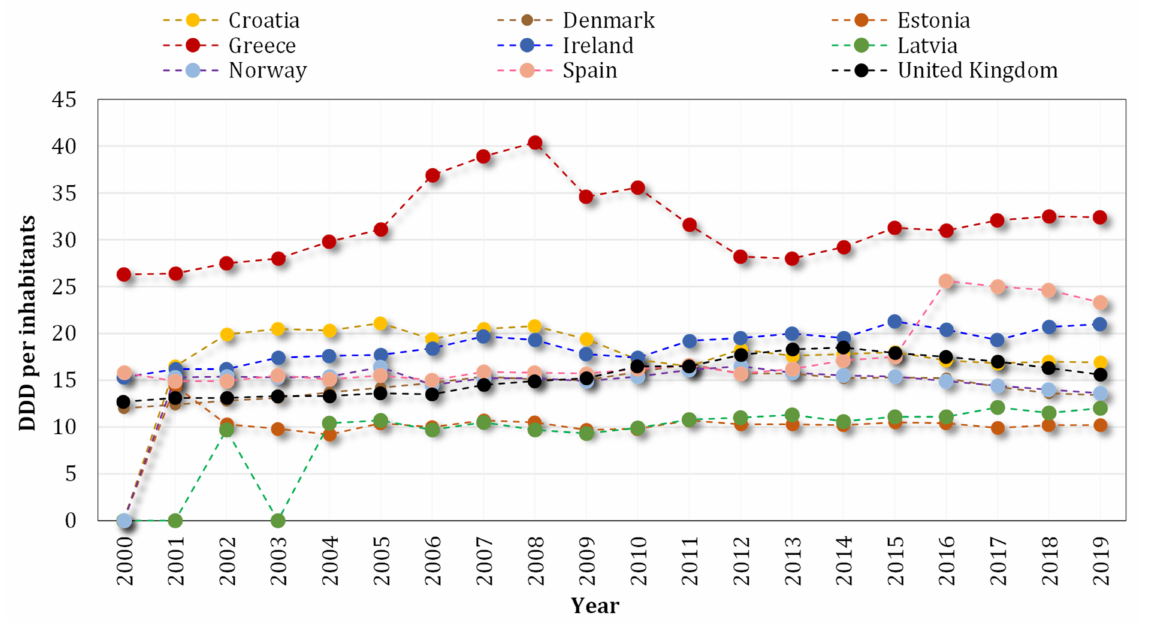
Figure 2. The increasing consumption trend of antibiotics in some European countries from 2000 to 2019. Defined daily dose (DDD) per 1000 inhabitants per day. Data source: